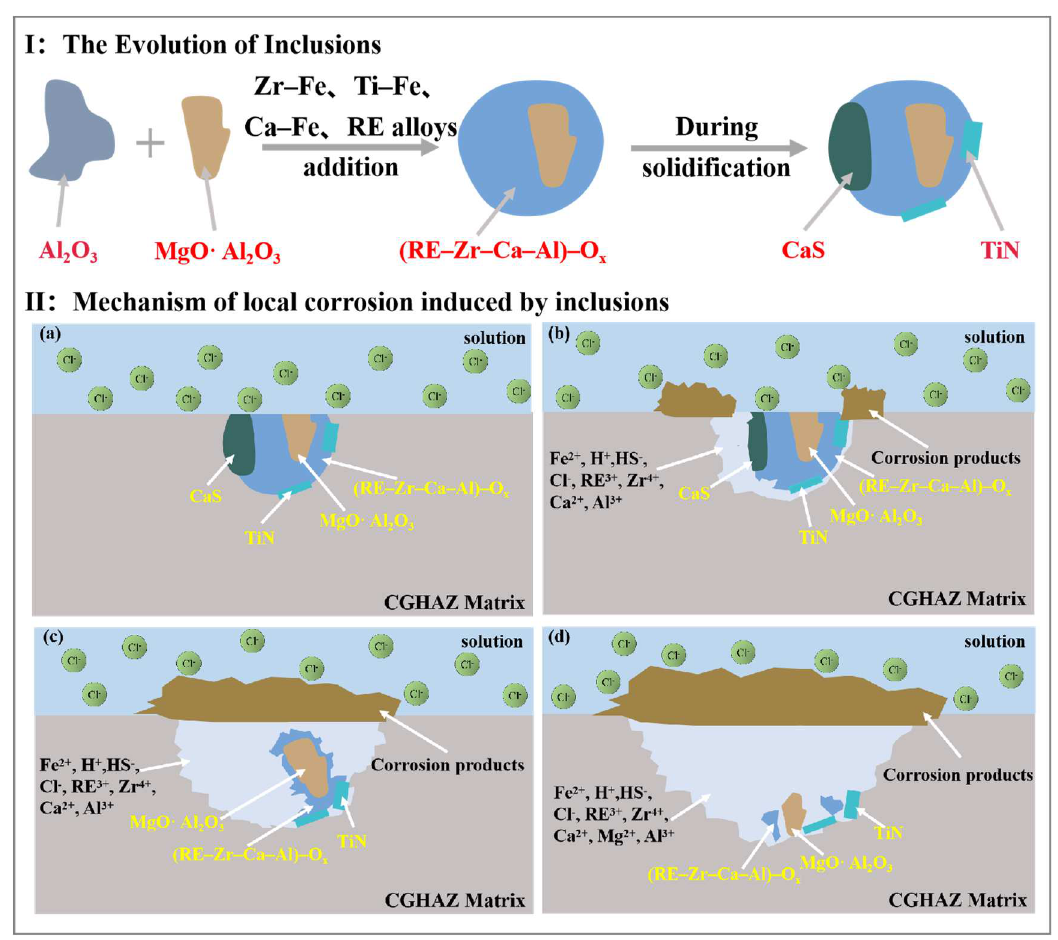
Figure 12. ( I ) Schematic diagram of the inclusion evolution process and ( II ) pitting initiation and propagation process induced by the composite inclusions. ( a ) before immersion, ( b ) pitting initiation, ( c ), ( d ) pitting propagation .